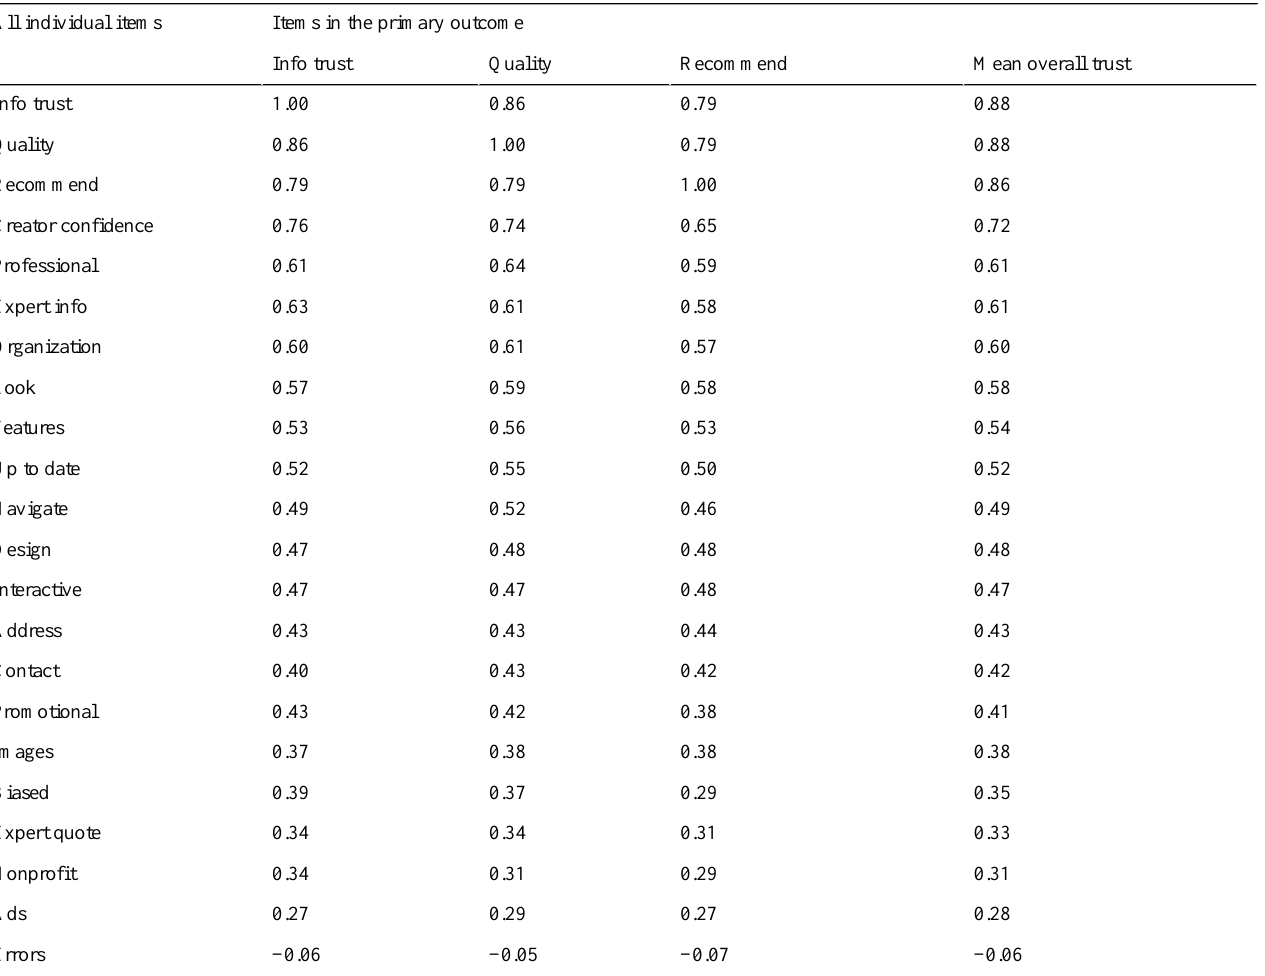
Table 4. Correlation coefficients between items in the primary outcome of mean overall trust and all individual items for all websites. Items in the primary outcomeAll individual